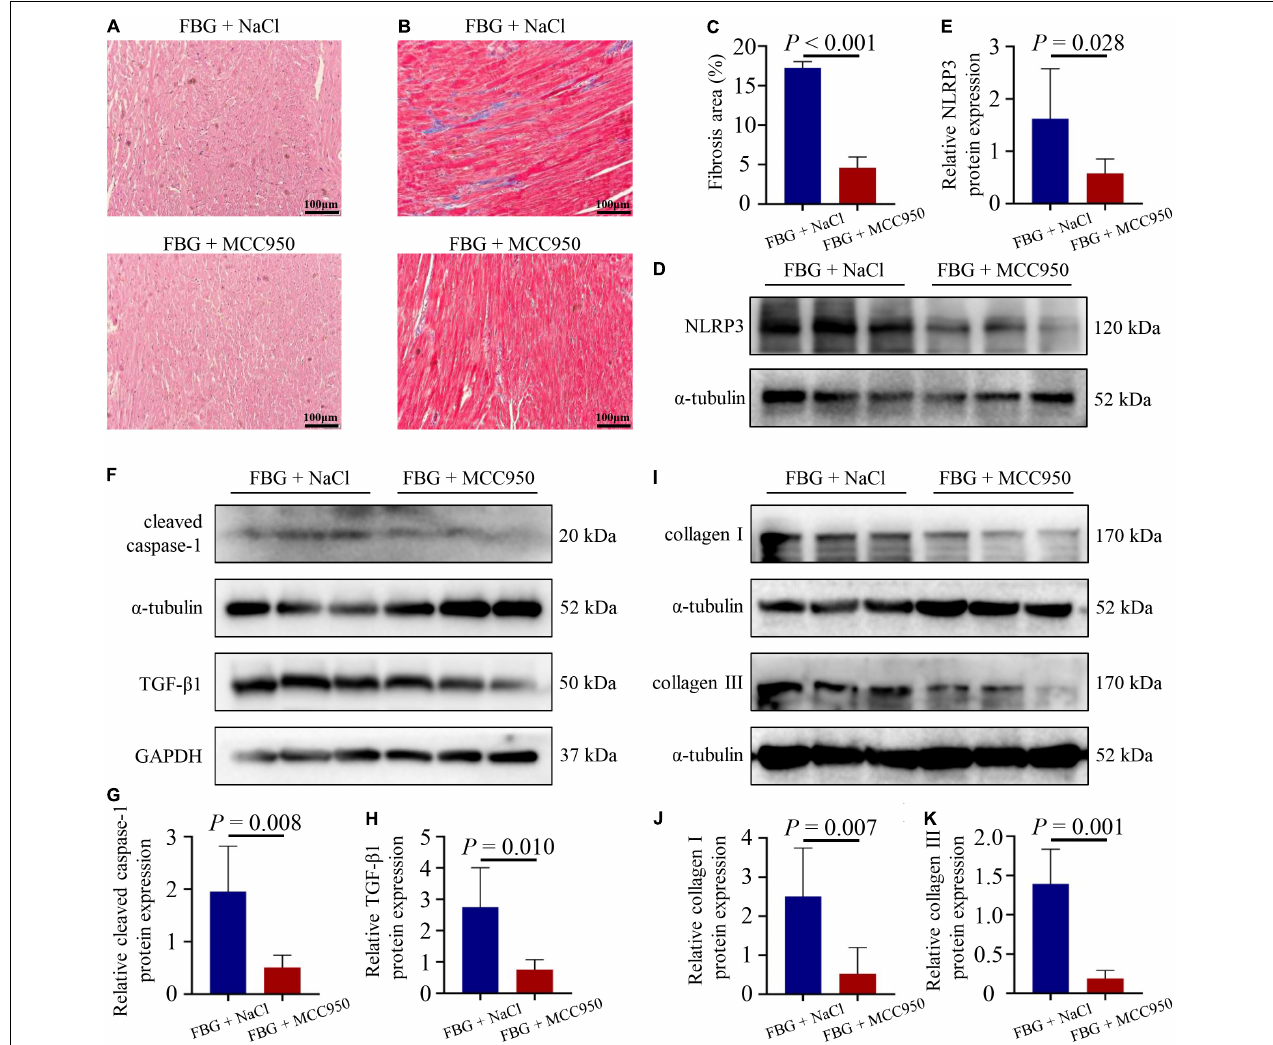
FIGURE 7 | NLRP3 inhibition with MCC950 reversed myocardial fibrosis induced by glucose fluctuations. (A) Representative images of hematoxylin and eosin (HE) staining for myocardial tissue in the FBG + NaCl and FBG + MCC950 groups ( n = 3 per group). (B–C) Representative images of myocardial fibrosis and fibrosis area (%) in the FBG + NaCl and FBG + MCC950 groups ( n = 4 per group). (D–K) The protein expressions of NLRP3, cleaved caspase-1, TGF- β 1, collagen I and collagen III in the FBG + NaCl and FBG + MCC950 groups ( n = 6 per group).